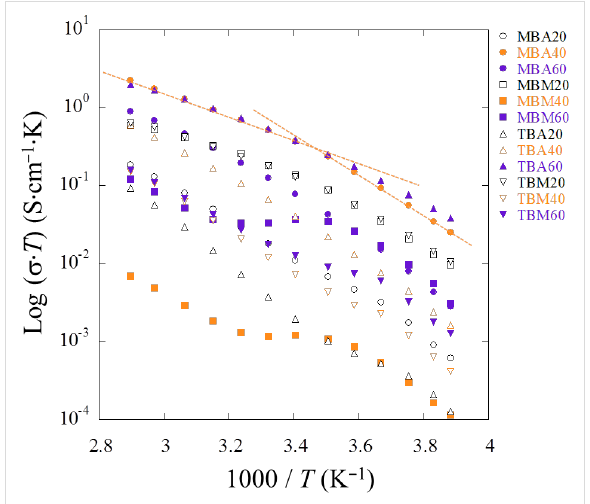
Figure 13: Variation of log( σ · T ) versus 1000/ T for all IGs. The change in the energy of activation likely does not stem from a weight loss process such as a weak dehydration because there is no apparent thermal event below 100 °C. However, data collected by DSC clearly show a transition at around − 9 °C. This is reasonably close to 12 °C, i.e., 1000/ T = 3.5 K − 1 , where the change in E a occurs. Le Bideau and coworkers performed quasi-elastic neutron scattering experiments to address the presence of a soft transition responsible of the change in the conductive dynamics [52] but as there are no data available for the present system we prefer to not speculate about the details of the